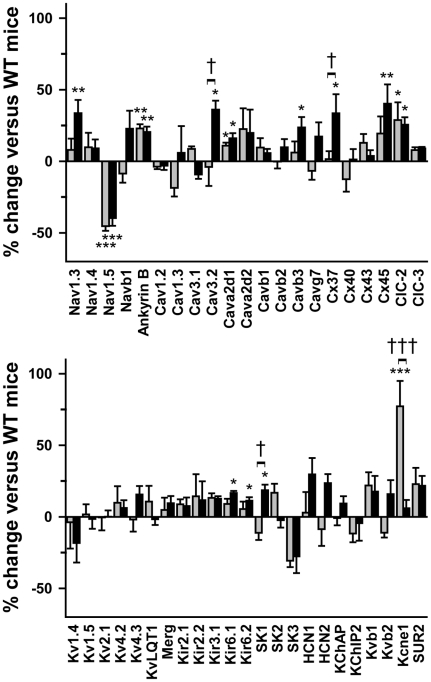
Moderate ionic remodeling in Scn5a
+/− mice.Percentage of variation in ventricular expression (Y-axes) of 46 genes encoding ion channel subunits (ch) and connexins (Cx) in Scn5a
+/− mice with mild (grey bars; n = 5) and severe (black bars; n = 7) phenotype versus WT mice (n = 10). Sub, subunits. *, **, ***, p<0.05, p<0.01 and p<0.001 respectively versus WT; †, †††, p<0.05 and p<0.001 respectively versus mild phenotype.